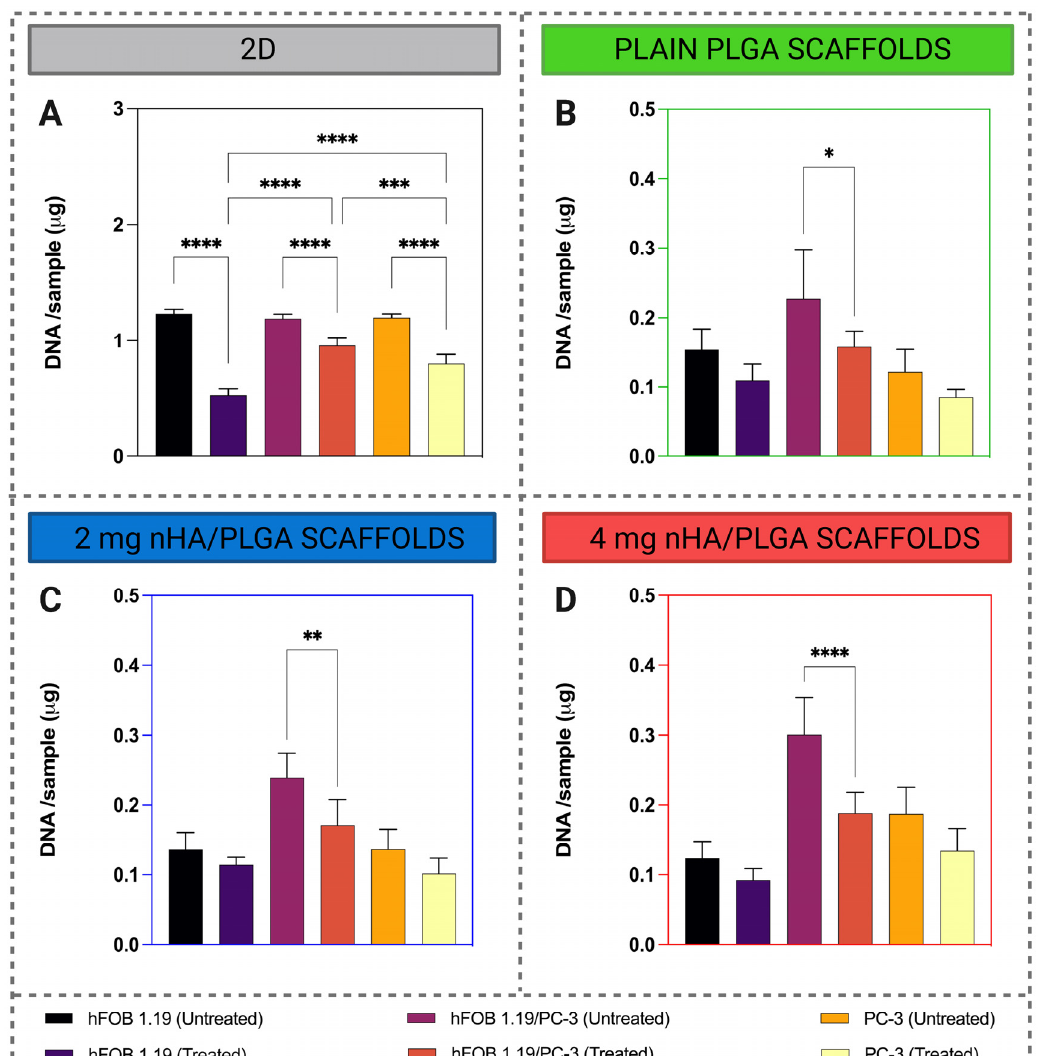
Figure 11. Quantification of the cytotoxic effect of 10 nM docetaxel in ( A ) 2D and 3D, ( B ) plain, ( C ) 2 mg nHA/PLGA, and ( D ) 4 mg nHA/PLGA scaffolds in mono- and co-culture. The total DNA/sample is expressed as the mean ± SD. The data represents 2 independent experiments and a total of n = 6 replicates per sample type. Note: different scales on the y-axis are used in B-D due to the lower DNA yield in 3D cell cultures. * p < 0.05, ** p < 0.01, *** p < 0.001, **** p < 0.0001.